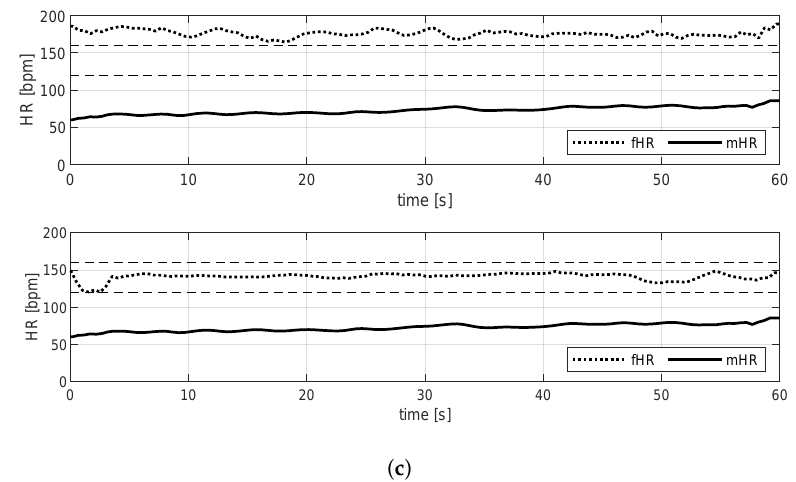
Figure 13. Examples of outcomes on DS-R. Comparison of fHR (dot) and mHR (line) estimation by VA and by the proposed method (upper and lower, respectively). ( a ) Real Acquisition 1. ( b )